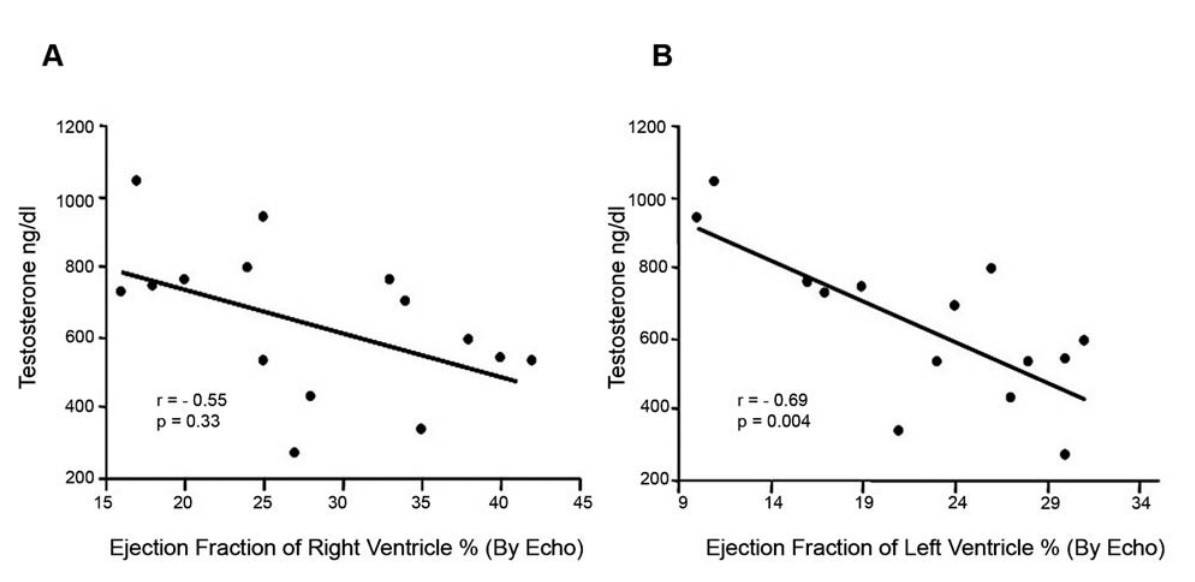
Figure 1 – A) Regression linear plots in all patients between total testosterone and right ventricular ejection fraction (%, by echog- raphy). B) Regression linear plots in all patients between total testosterone serum levels and left ventricular ejection fraction (%, by echography).